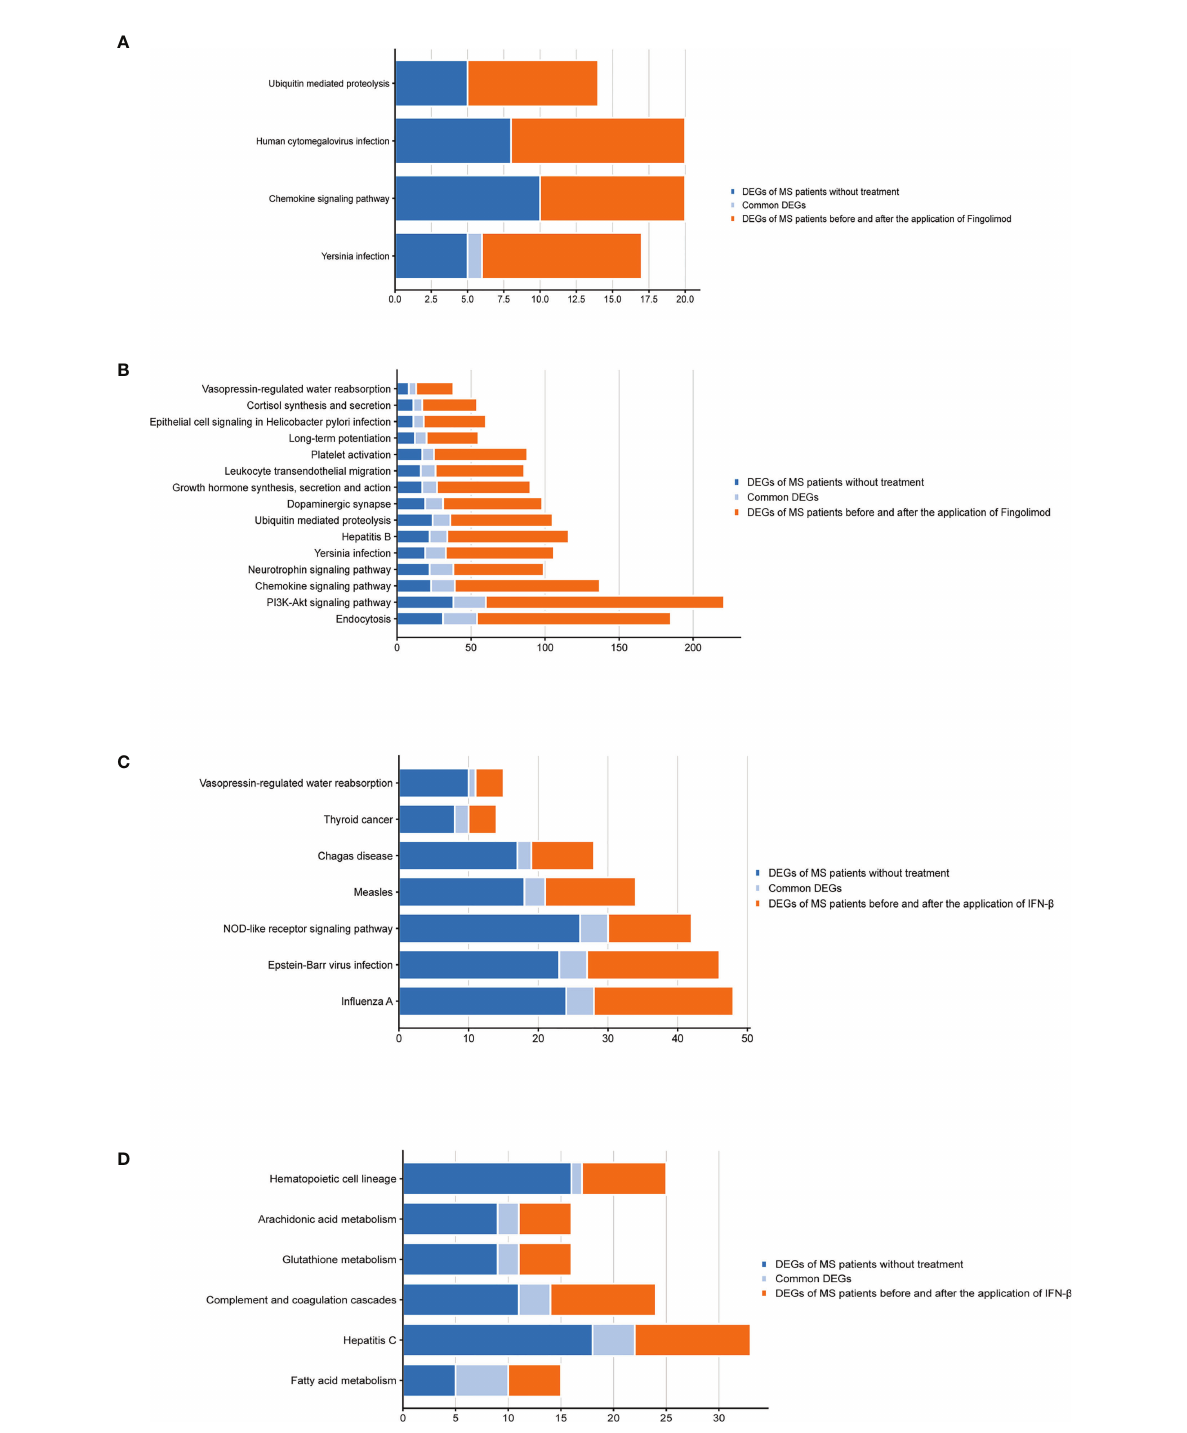
FIGURE 6 Bar graphs of the target pathways in MS patients treated with Fingolimod or IFN- b . (A) DEGs contained in the target pathways of CD19+ B cells in MS patients treated with Fingolimod; (B) DEGs contained in the target pathways of CD4+ T cells in MS patients treated with Fingolimod; (C) DEGs contained in the target pathways of pDCs in MS patients treated with IFN- b ; (D) DEGs contained in the target pathways of PBMC in MS patients treated with IFN- b